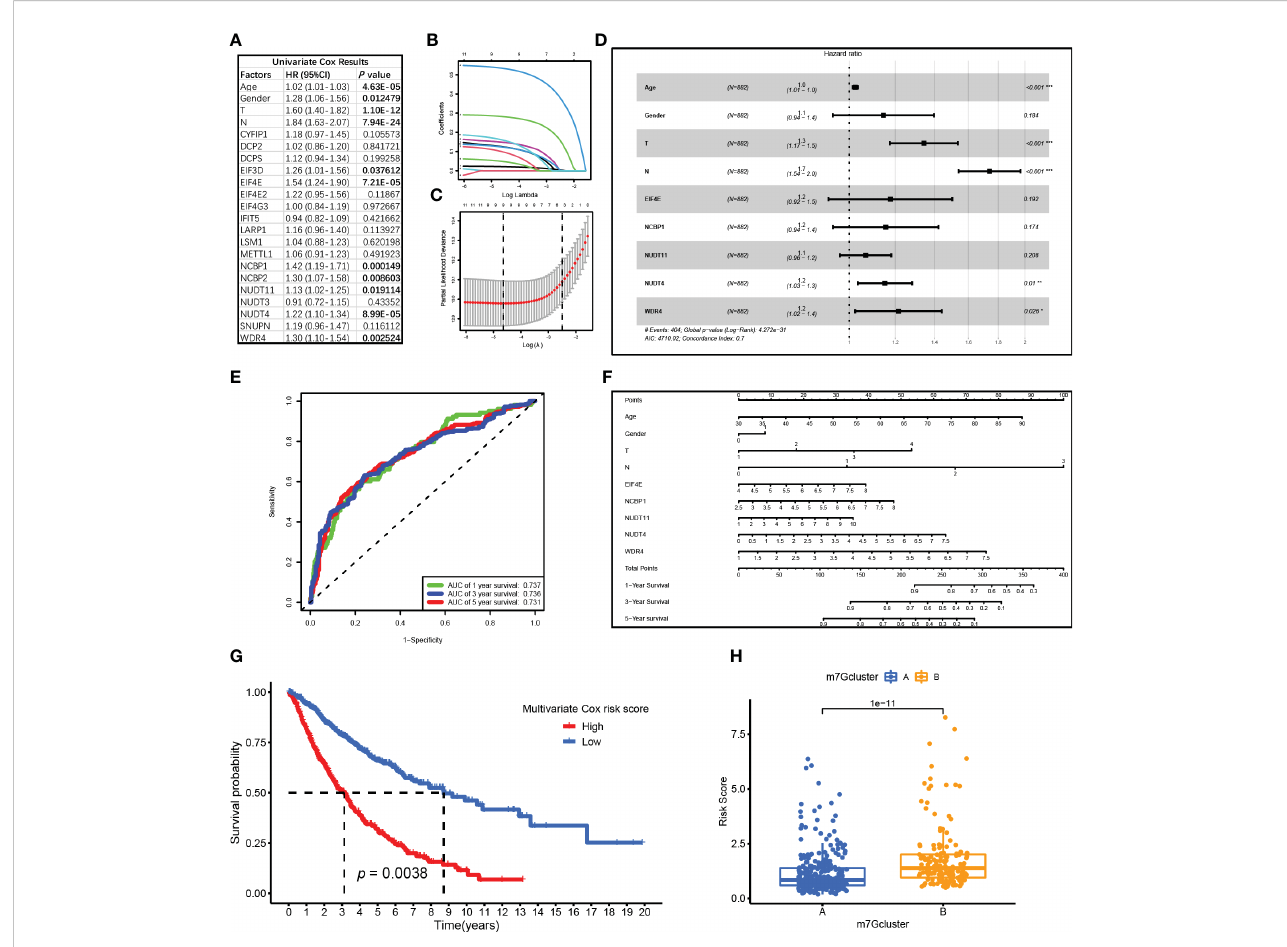
FIGURE 4 Cox regression analysis for N7-methylguanosine (m7G)-related genes and clinical characteristics. (A) Univariate Cox regression analysis results of m7G- related genes. (B) Coef fi cient plot for each factor coef fi cient. (C) The partial likelihood deviance plot showed partial likelihood deviance of each model. (D) Forest plot showed multivariate Cox regression analysis results of the nine factors. (E) ROC curve showed the survival prediction model performance. (F) The nomogram for survival prediction model. (G) Survival analysis between high-risk and low-risk groups. (H) Boxplot showed Cox risk scores between the two m7G clusters. ROC: Receiver operating characteristic curve; AUC: Area under curve. (*P <0.05, **P < 0.01, ***P <